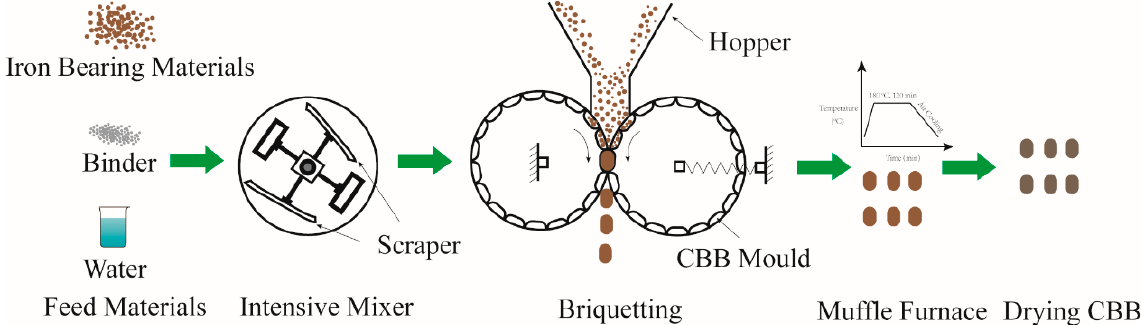
Figure 3. Diagram showing the process of preparing the